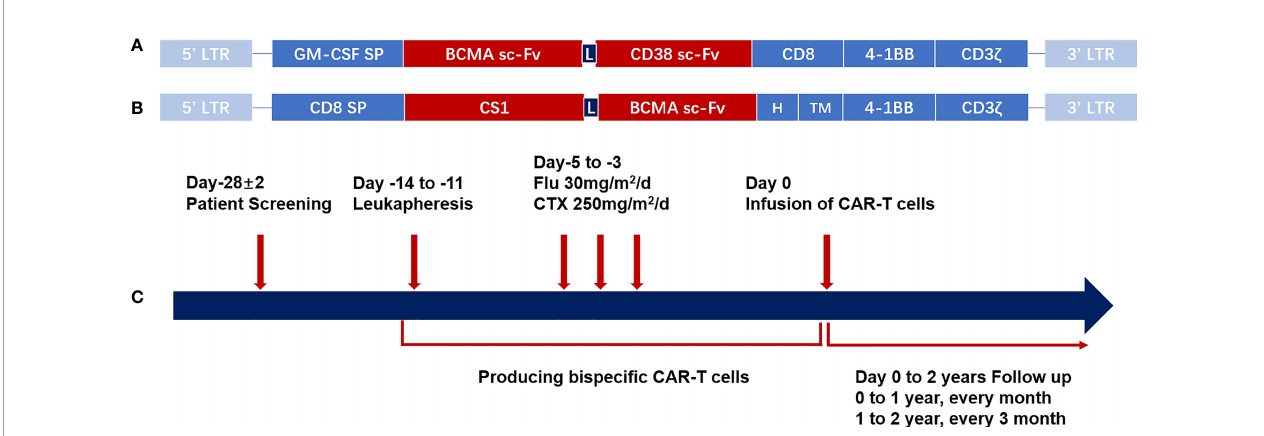
FIGURE 1 | CAR structure and schema of the CAR-T cell therapy. (A) Schematic structure of bispeci fi c BM38 CAR. The bispeci fi c BM38 CAR contains an anti- BCMA scFv and an anti-CD38 scFv in tandem in 4-1BB-containing second-generation formats. (B) Schematic structure of BCMA/CS1 bispeci fi c CAR. The BCMA/ CS1 bispeci fi c CAR contains an anti-CS1 scFv and an anti-BCMA scFv in 4-1BB-containing second-generation formats. (C) Diagrammatic sketch of CAR-T cell therapy. After screening for eligibility, PBMCs were collected by leukapheresis for the production of bispeci fi c CAR-T cells, and then patients receive lymphodepleting regimens consisting of CTX (250 mg/m 2 /day, days − 5 to − 3) and FLU (25 mg/m 2 /day, days − 5 to − 3). Regular follow-up should be continued after the infusion of CAR-T cells. CAR, chimeric antigen receptor; CAR-T, chimeric antigen receptor-modi fi ed T cell; BCMA, B-cell maturation antigen; scFv, single-chain variable region;